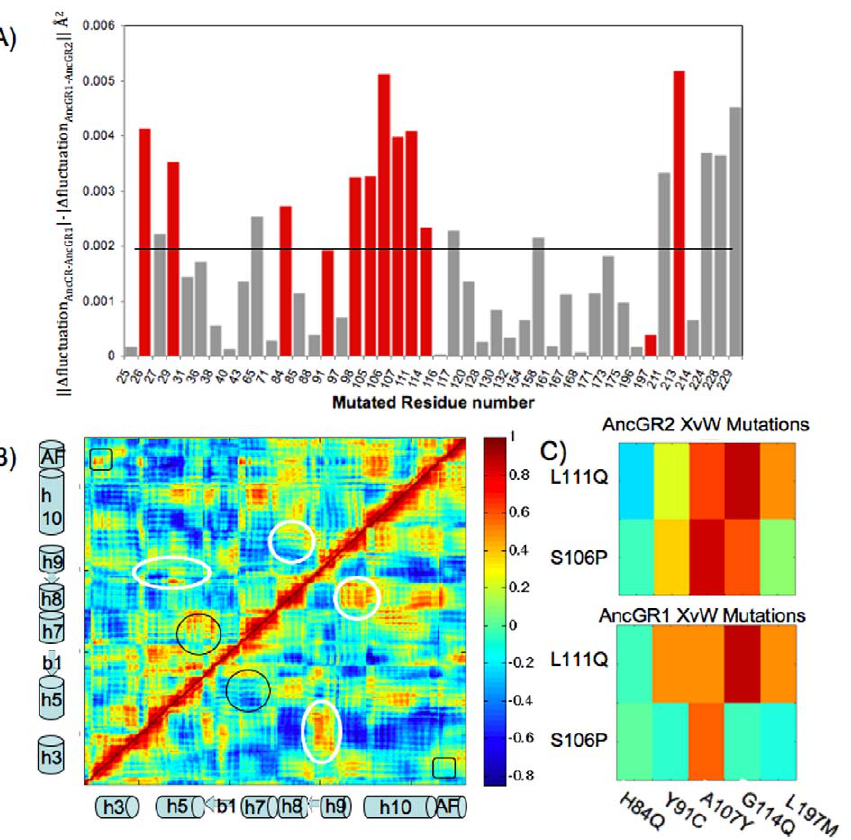
Figure 4. The change in net fluctuations and correlations of the mutated residues for successive evolution of MR to GR proteins. (A) The change in net fluctuation between successive ancestral proteins, AncCR, AncGR1 and AncGR2 for mutated residues. Those residues identified as critical to alter-function are noted in red. The activation-function (AF) helix contains mutations 224 and 229. A cutoff (solid line) results in all critical mutations identified except for Y91C and L197M. Y27R is noted as critical to function but sites 65, 117, and 158 are false positives. (B) The cross correlation map with AncGR2 on the upper left and AncGR1 on the lower right. Circled in black are changes in the cross correlation associated with critical residues near the binding pocket. Squared in black are the changes in cross correlation due to critical mutation N26T forming a hydrogen bond with the AF-helix. Circles in white are additional changes in cross correlation not associated with critical mutations. (C) The cross correlations between the X and W mutations. The correlation between X and W mutations is higher for AncGR2, whereas AncGR1 X functional mutations are uncorrelated, increasing the flexibility in the binding pocket and allowing for promiscuous binding.